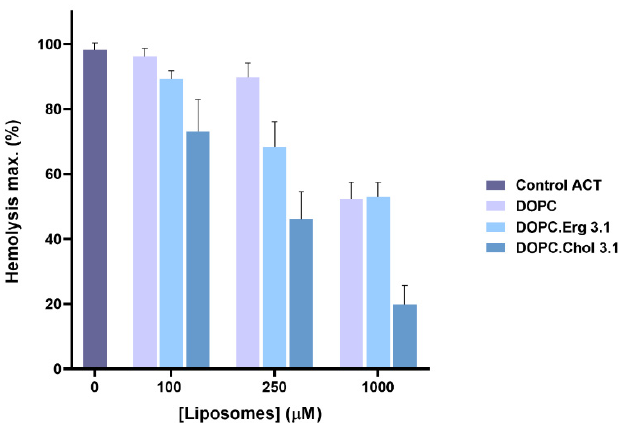
Figure 3. Effect of ACT preincubation with liposomes of different lipid composition on ACT-induced haemolytic activity. ACT (50 nM) was preincubated for 30 min at RT in the presence of liposomes of different lipid compositions (DOPC, DOPC:Chol 3:1 and DOPC:Erg 3:1 molar ratio) at different total lipid concentrations (0–1000 µM). Then sheep erythrocytes at a density of 5 × 10 8 cells/mL were added and the mixture was further incubated for 180 min at 37 °C. Haemolytic activity was measured as decrease of turbidity at 700 nm and expressed as haemolytic percentages (calculated as detailed in the Experimental Procedures section). Data represented in the figure correspond to the mean of three independent experiments ± SE.